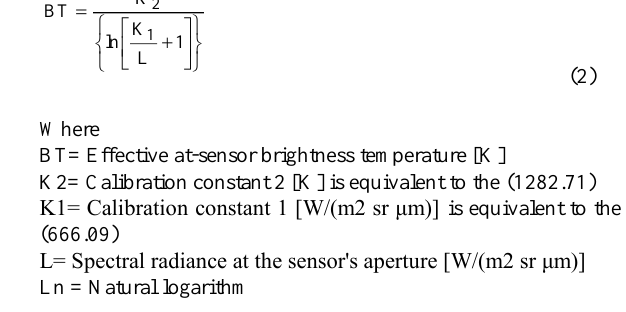
Figure 1. Location of case study area (22 zones of Tehran)